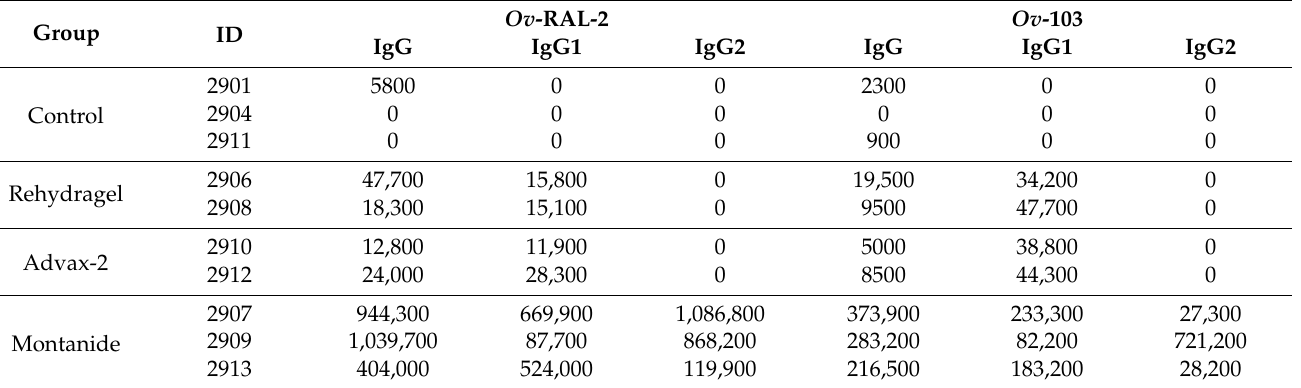
Table 1. Antigen-specific total IgG, IgG1 and IgG2 antibody titres in immunogenicity trial calves at